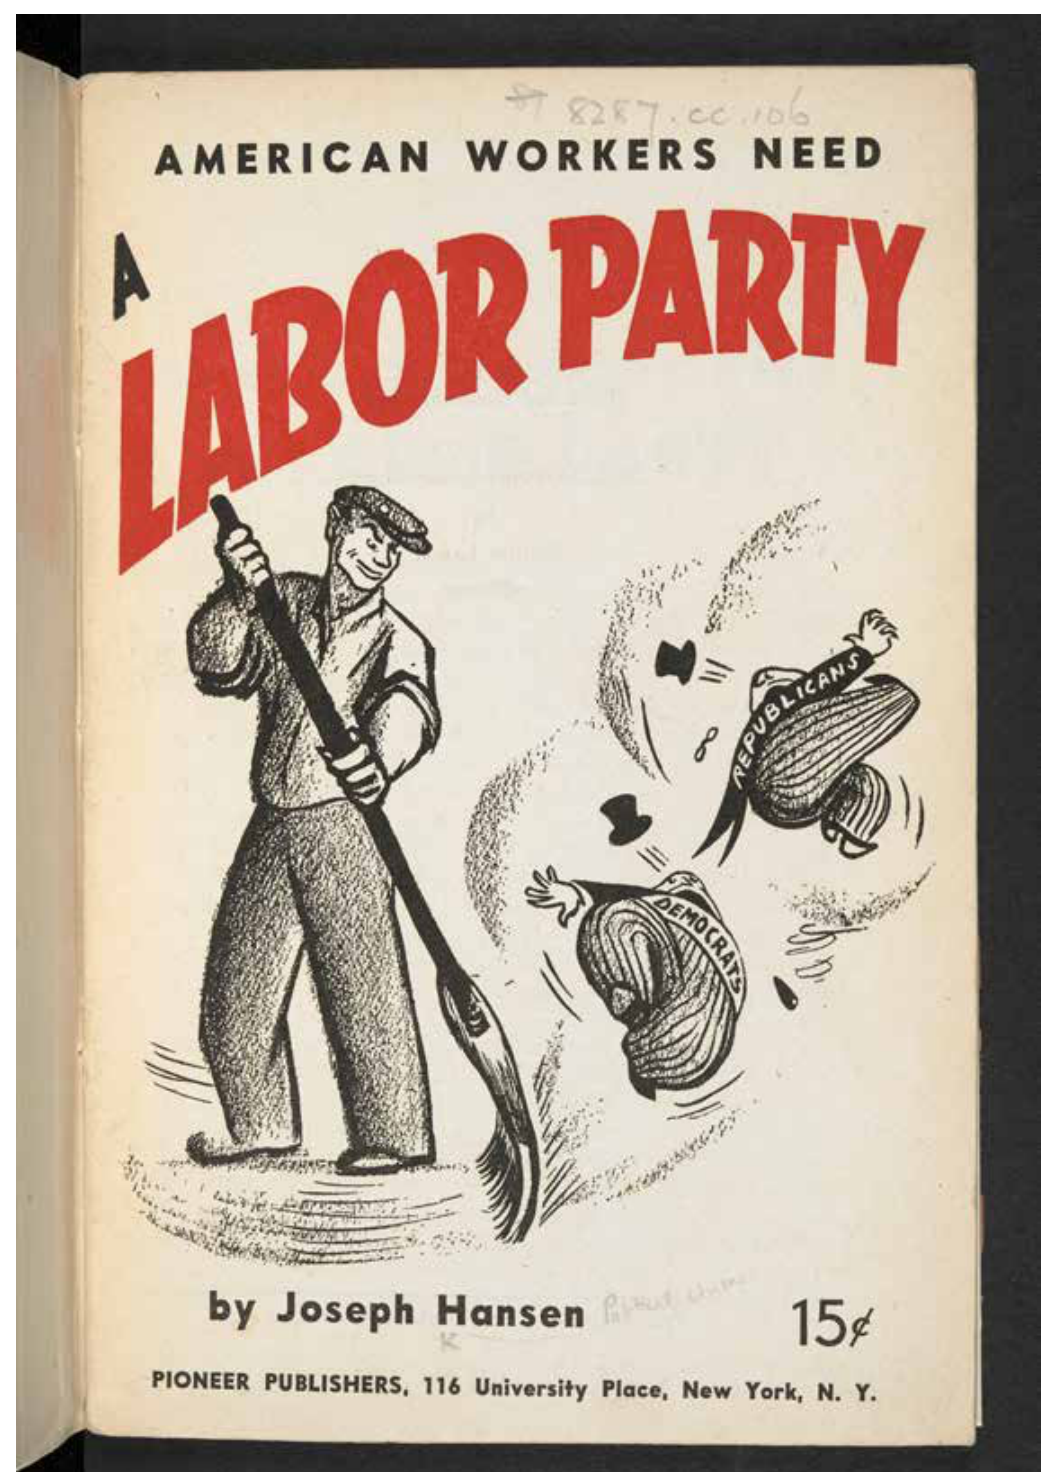
Fig. 3. Joseph Hansen, American Workers Need a Labor Party (New York: Pioneer Publishers, 1944). BL,